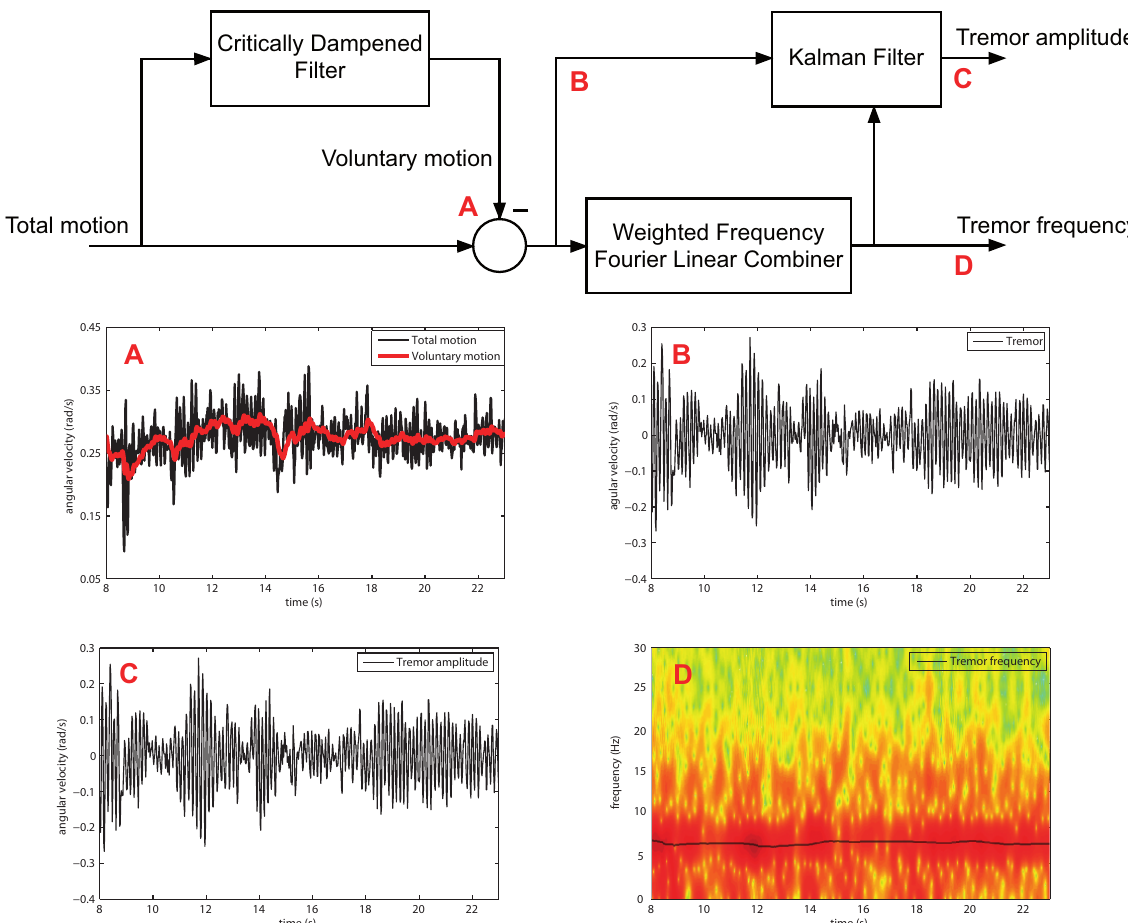
Figure 8 . Block diagram summarizing the two stage algorithm for real-time estimation of instantaneous tremor parameters. First, a Critically Dampened Filter estimates voluntary motion from raw kinematic data. Next, we generate an estimation of tremor by subtracting voluntary from raw movement. At the sec- ond stage, the Weighted Frequency Fourier Linear Combiner estimates instantaneous tremor frequency, and then feds it into a Kalman Filter that tracks instantaneous tremor